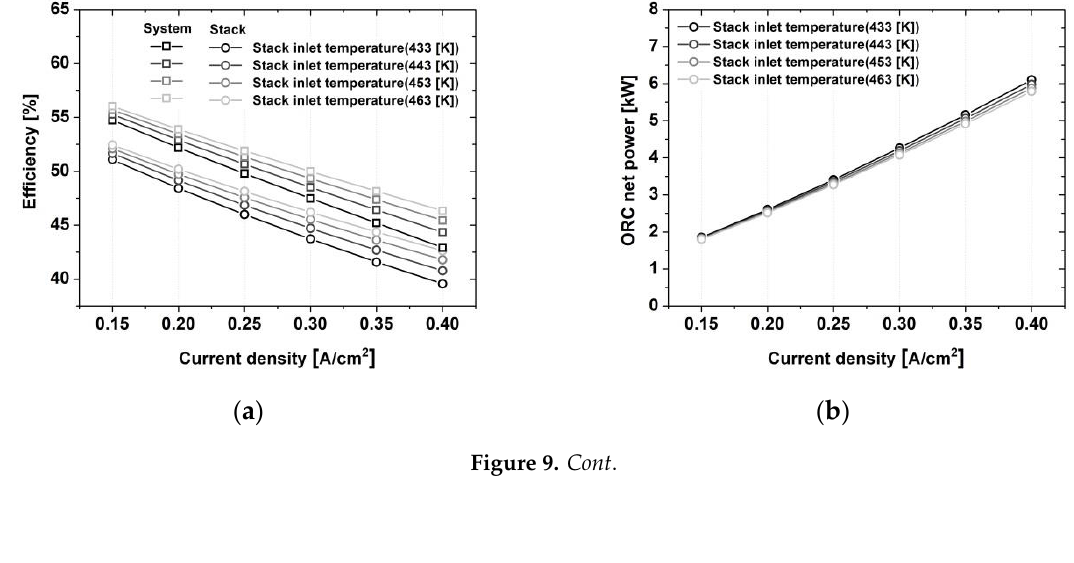
Figure 8. Validation trends of system loss and mass flow rate with stack inlet temperature. ( a ) Cooling pump mass flow rate; ( b ) Evaporator TEG side mass flow rate; ( c ) Stack pressure drop; ( d ) Evaporator TEG side pressure drop.